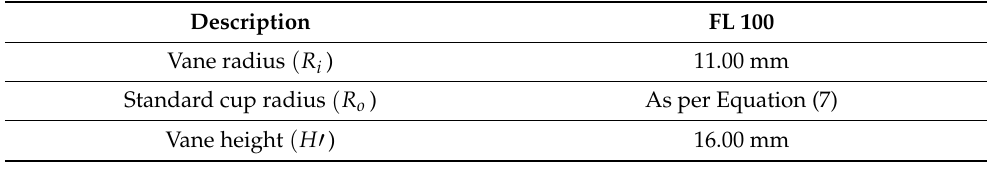
Figure 4. Schematic representation of vane rheometer. Table 6. Vane dimensions.